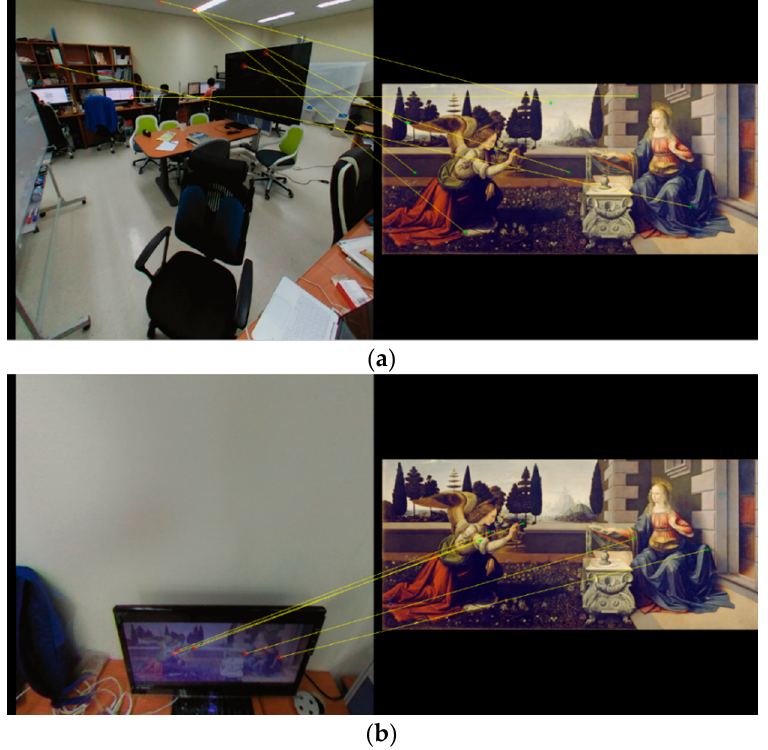
Figure 11. An example of false and correct matches. ( a ) False matches; ( b ) Correct matches.